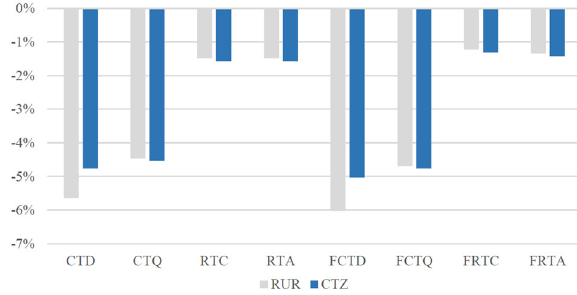
Fig. 4 Social welfare change in 2030 based on BAU scenario. RUR for rural residents, CTZ for urban